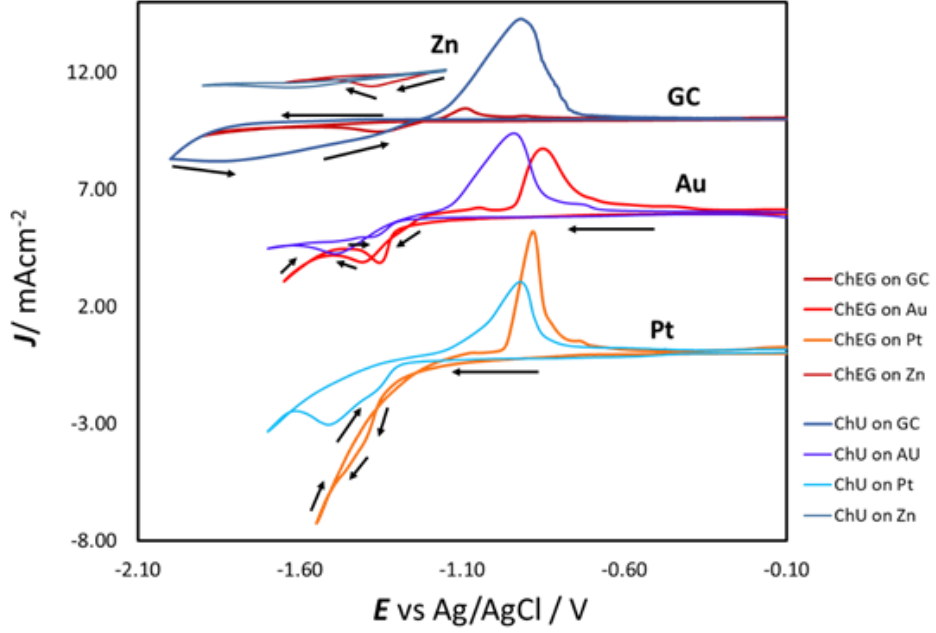
Figure 2. Cyclic voltammograms of 0.3 M ZnSO 4 in ChU (blue shades) and 0.3 M ZnSO 4 in ChEG (red shades) with GC, Au, Pt and Zn electrodes. The arrows indicate the direction of the cycle. When ZnSO 4 is dissolved in DESs, the [ZnCl 4 ] 2 − species is formed and stabilized by The CVs on GC for both electrolytes show that the cathodic peaks at −1.75 V (ChU) choline [18,19]. Although tetrachlorozincate is the dominant species, it does not seem to be the complex from which Zn is deposited; indeed, [ZnCl 4 ] 2 − has a very negative reduction potential. Vieira et al. [20,21] suggested the formation of an intermediate electroactive species triggered by the cathodic reaction of the electrolyte. Figure 3 shows CVs in which the cathodic limit was gradually increased from − 1.5 to − 1.9 V, and one can notice that the CD at the anodic peak increases with the lower vertex potential. At the same time, the reduction peak at − 1.5 V is only visible at lower scan rates, which is anticorrelated with the CD (Figure 4). In any case, in Figures 3 and 4, no reduction peak could be detected in the investigated ranges of cathodic vertex potential and scan rate. From these results, it can be inferred that the formation of the electroactive intermediate resulting from the replacement of one or more chloride ligands in [ZnCl 4 ] 2 − with a cathodic reduction product of EG and/or Ch should be a reaction with slow kinetics. Chronoamperometric measurements on GC, which will be discussed in Section 2.3.1, showed that Zn deposition is already present at − 1.35 V. Therefore, the formation of the electroactive intermediate also seems to show a notable time